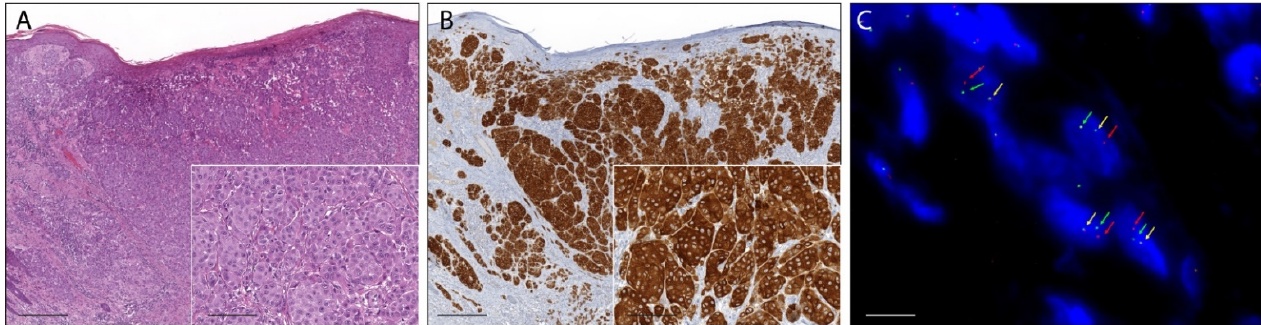
Figure 1. Photomicrographs of an atypical Spitz tumor harboring anNTRK1 fusion. ( A ): The lesion was an exophytic nodule with epidermal collarette, flat lower border, and focal epidermal hyperplasia with filigree-like rete ridges (H&E staining, magnification 40×, scale bar: 200 µm). Inset: lobulated nests of epithelioid melanocytes with distinct cell borders and quite pleomorphic nuclei (H&E staining, magnification 200×, scale bar: 40 µm). ( B ): Melanocytes showed strong and diffuse cytoplasmic immunoreaction (pan-TRK immunostaining, magnification 40×, scale bar: 200 µm). Inset: pan-TRK cytoplasmatic immunoreaction (pan-TRK immunostaining, magnification 200×, scale bar: 40 µm). ( C ): Break-apart FISH analysis confirmed NTRK1 rearrangement showing the typical pattern: one fusion signal (yellow arrows) and split signals 3 ′ (red arrows) and 5 ′ (green arrows) (ZytoLight SPEC NTRK1 Dual Color Break Apart Probe, original magnification 1000×, scale bar: 5 µm).